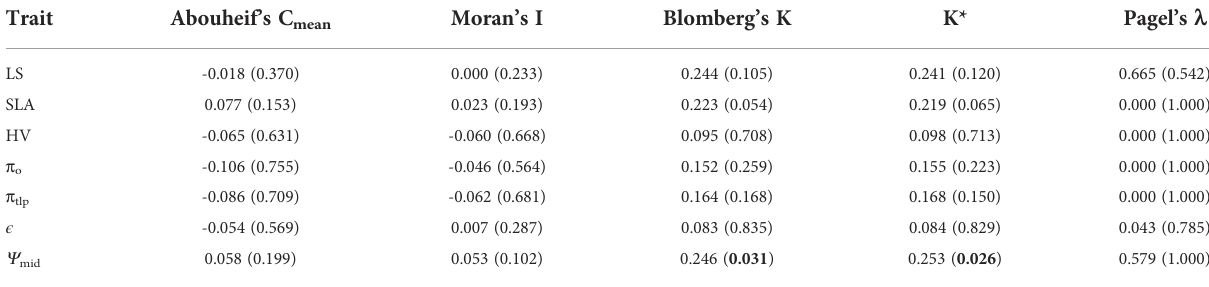
C mean isameasureofautocorrelationofthecovariationoftraitvaluesrelativetothephylogeneticdistancesbetweenthespecies.C mean =1signi fi esstrongresemblanceacrosscloserelatives, andC mean = − 1signi fi esarobustnegativecorrelationbetweenspeciesandtraitresemblance.ThevaluesofBlomberg ’ sKsuggestthattraitdiscrepancyacrossaphylogenyisdiscerniblefrom Brownian motion. K > 1 suggests that phylogeny forecasts more trait difference than expected given Brownian motion due to trait conservation. K < 1, phylogeny forecasts less trait difference thanexpected under Brownian motionowing to phylogenetic traitconvergence (Perez andFeeley, 2020). Pagel ’ s l stands fora quantitative assessment ofthe phylogenetic signal for a trait and value of l between 0 and 1. l = 0 suggests that the trait has evolved independently from phylogeny. l = 1 suggests a robust phylogenetic signal. The intermediate values of l indicate that trait may have evolved by a process different than random drift (Krishna et al., 2021). Signi fi cant values (p < 0.05) were shown in